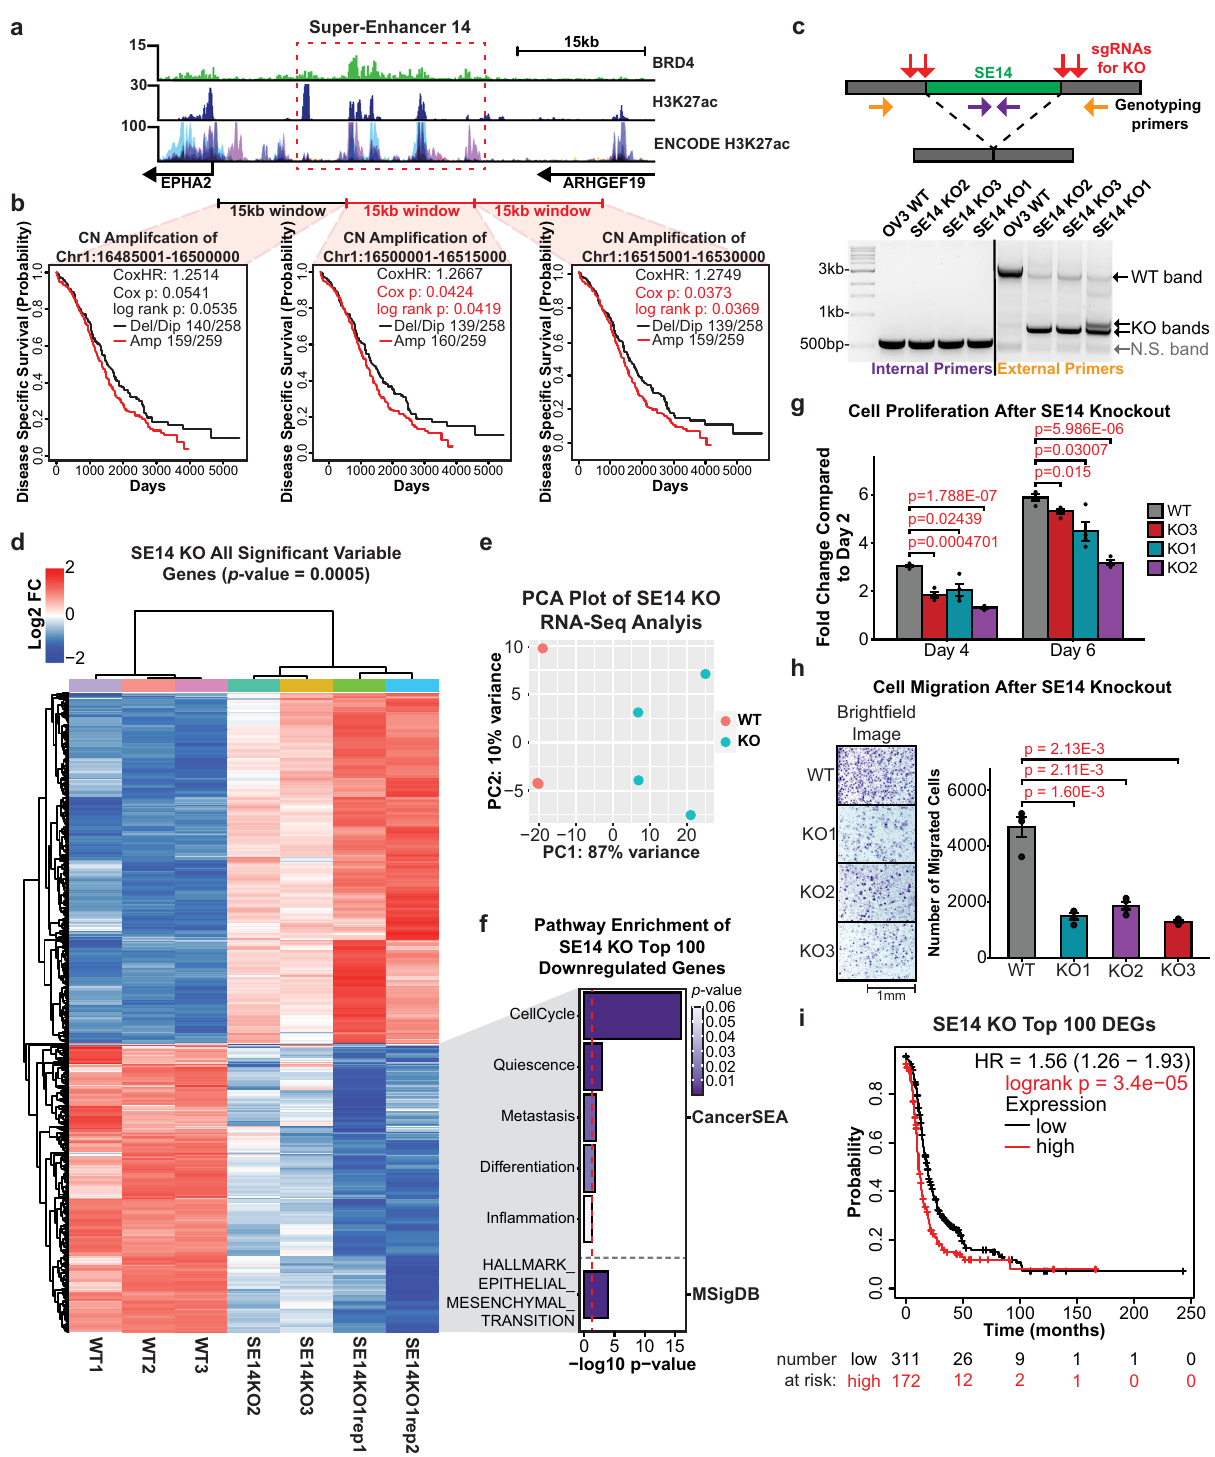
(Fig. 6c, d, Supplementary Fig. 6, and Supplementary Data 10). CNVeQTL analysis (Supplementary Fig. 9a, b, and Supplemen-